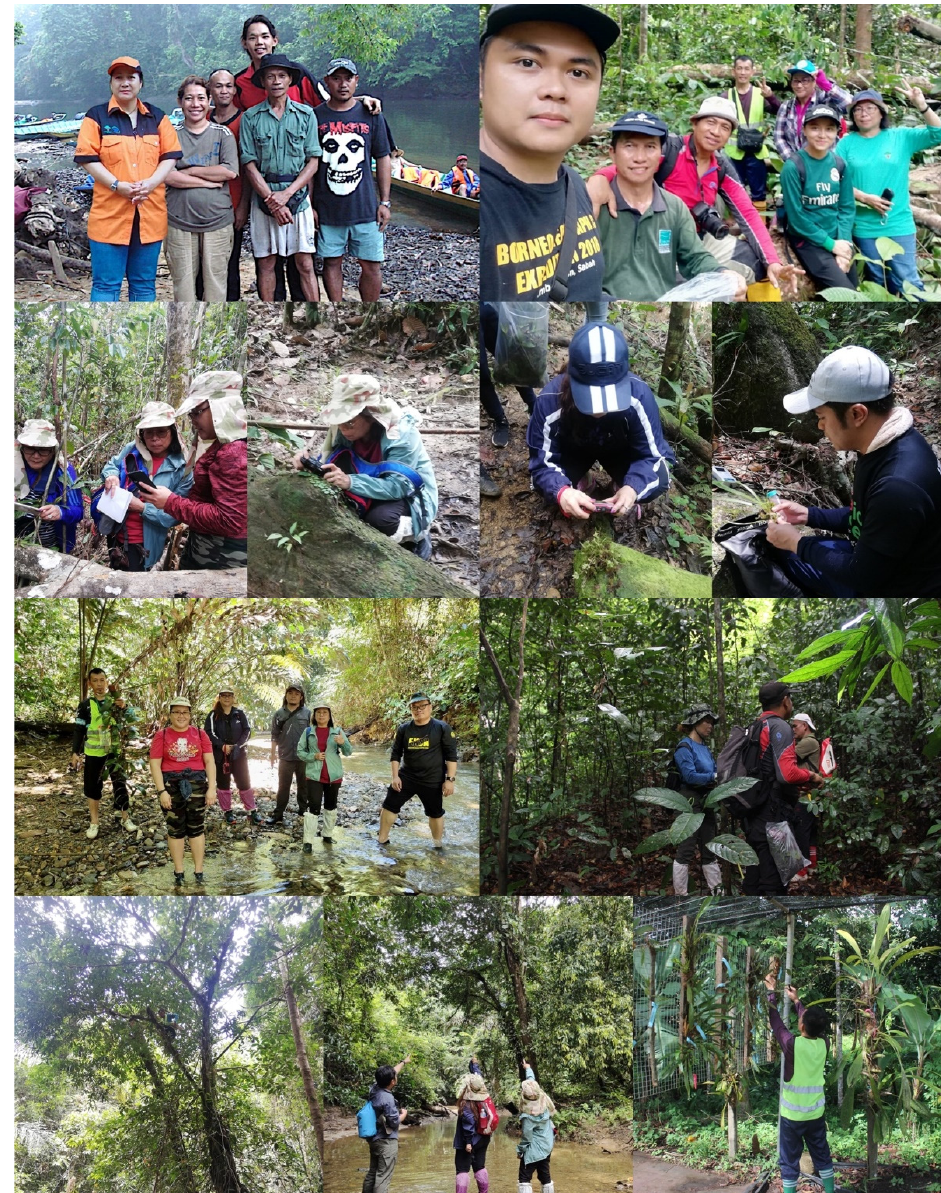
Figure 1. Discovery team (top left are the 2008 discovery team; others are the recent team).